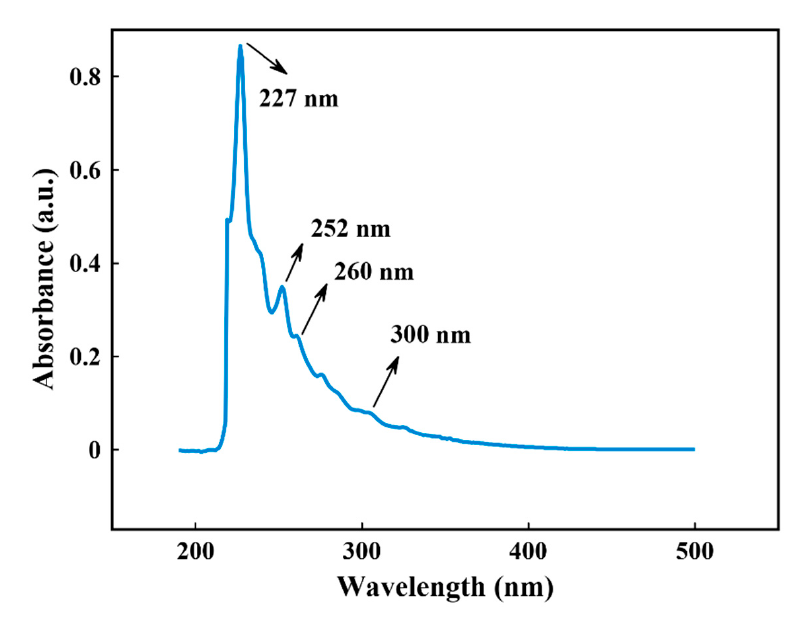
Figure 5. UV-Vis absorption spectrum of the CNPs suspension.